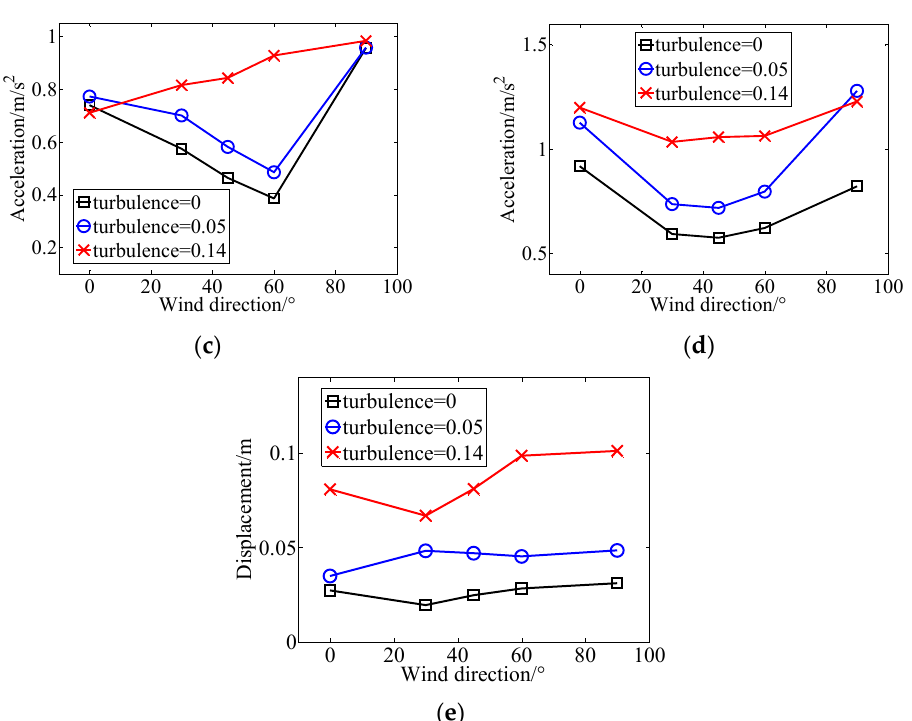
Figure 17. The results in the transient wind test: ( a ) Sensor 1; ( b ) Sensor 2; ( c ) Sensor 3; ( d ) Sensor 4; ( e ) Sensor 5.